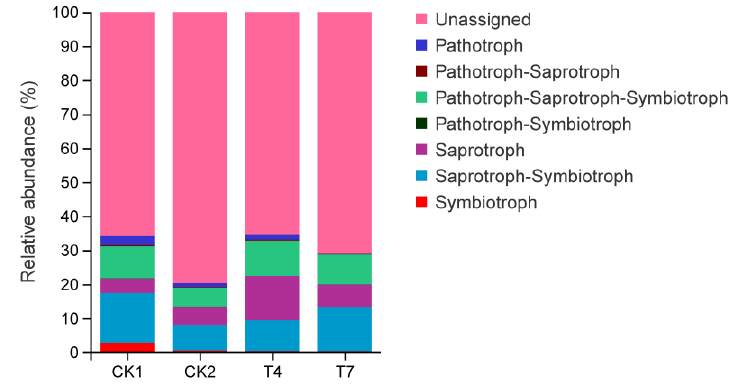
Figure 7. Prediction of fungal functions in different treated soils based on FUNGuild.